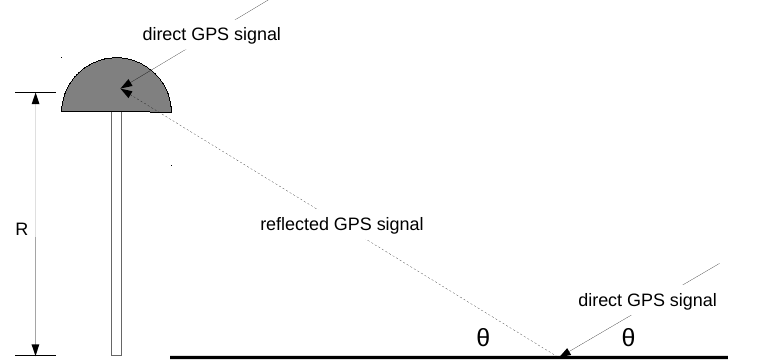
Figure 2. At low elevation angles, the interference between reflected and direct signals at the antenna enables GNSS Interferometric Reflectometry (GNSS-IR), a technique to study the reflecting surface properties, among which the variation of the reflector height R over